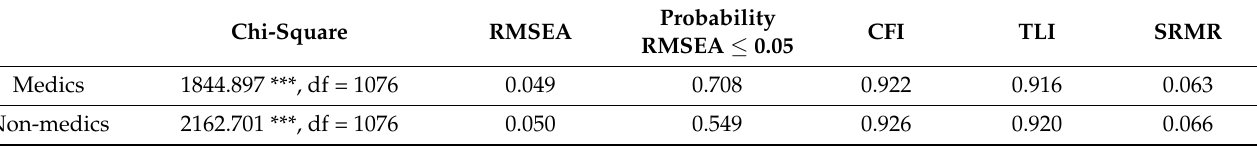
Table 2. Summary of comparison of fit indices of the model between medics and non-medics. Chi-Square RMSEA